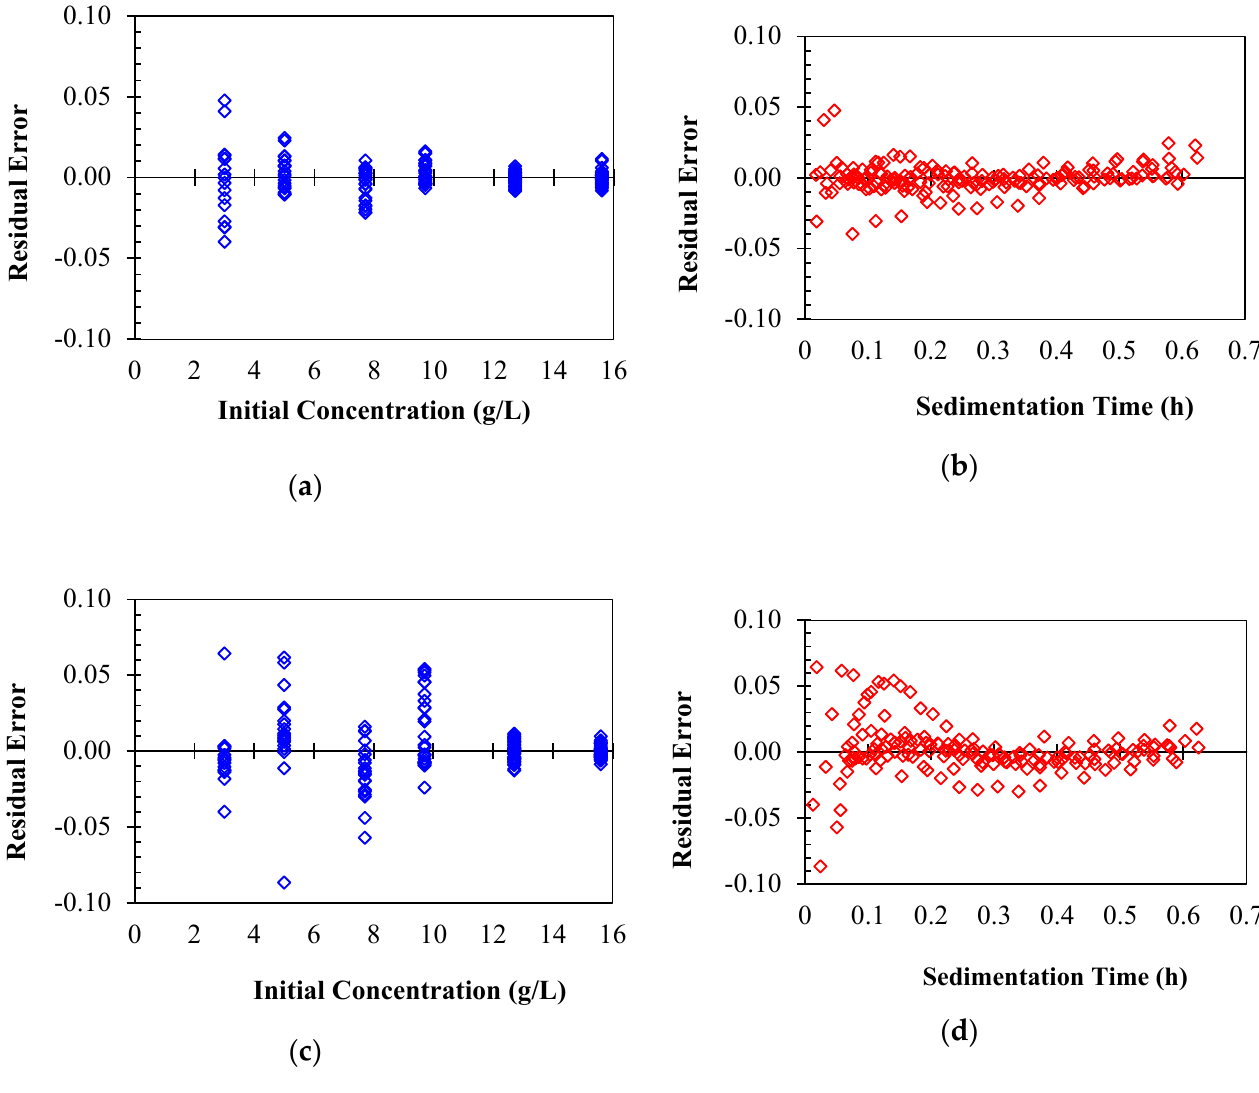
Figure 7. Residual errors between the measured settling behavior, borrowed from [21], and estimated behavior using VM- and LM-based correlations versus initial sludge concentration ( a , c ) and time ( b , d ), respectively.